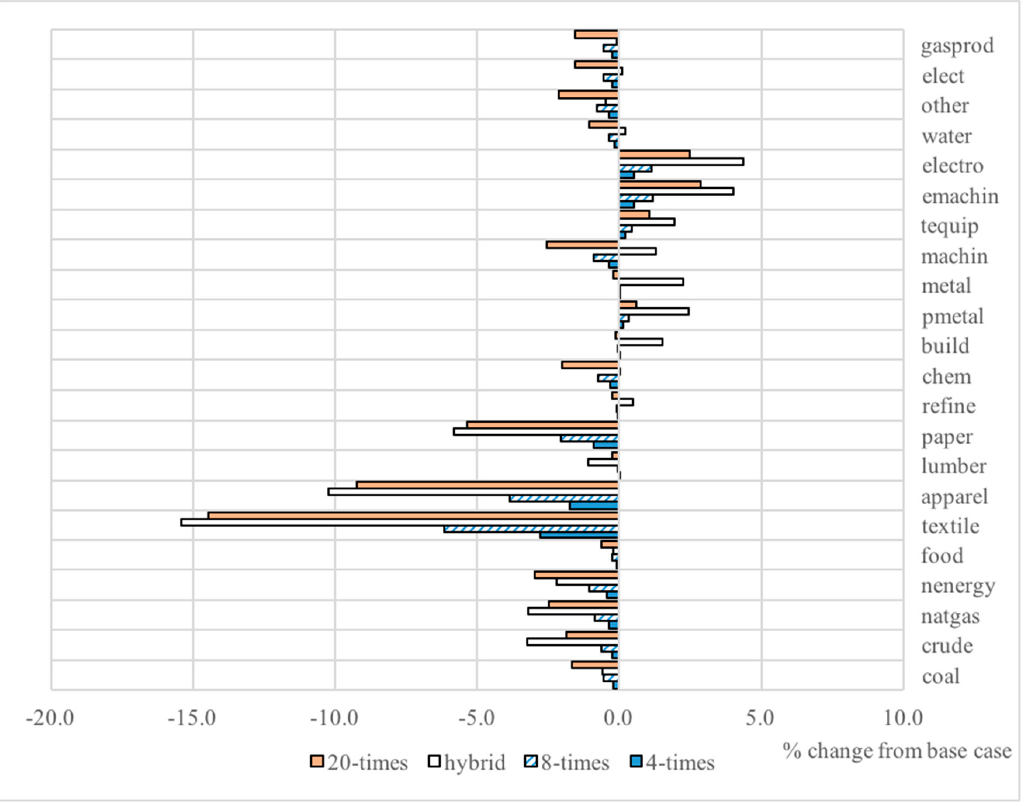
Figure 7. The impacts on freshwater discharge of 22 industrial sectors in 2030 (percent change). Negative values in the discharge change mean that the total COD discharge in the policy case is less than the total discharge in the baseline.